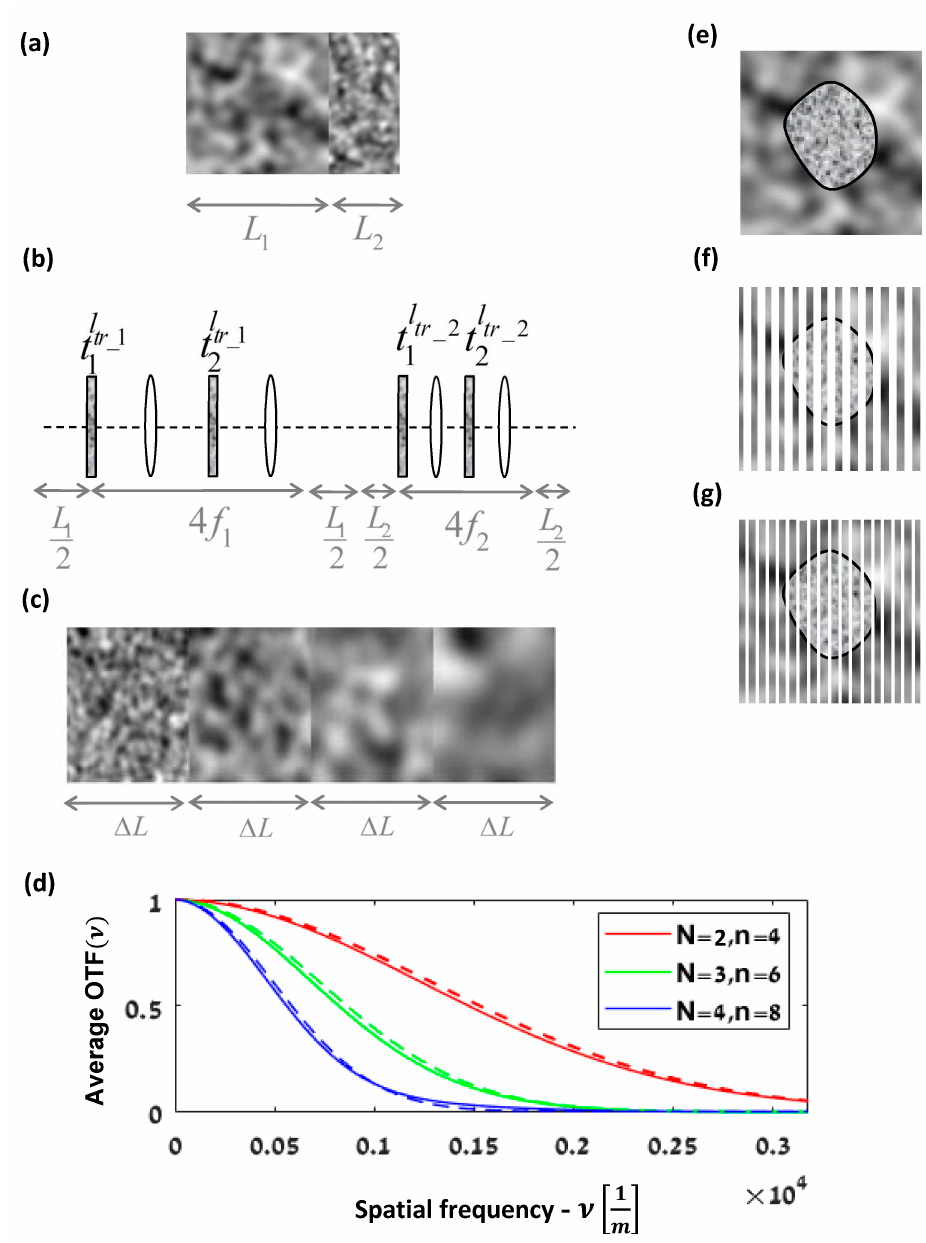
Figure 4. ( a ) Two adjacent media with different lengths and transport mean free path values, l tr . ( b ) Equivalent paraxial set-up to ( a ) with RSPs. ( c ) Concatenation of media with gradual change in their l tr . ( d ) The AOTF of the particular case where the medium in Figure 3a is replaced by the gradual medium change in Figure 4c. The graphs show the cases of two, three, and four cascaded media. The bold line represents the simulation result while the dashed line shows the expected analytical result from (9). (color online) ( e ) A known mantle random medium in the environment of another random medium. ( f ) Approximation of ( e ) as a stack of many RSPs. ( g ) A higher resolution of ( f ).